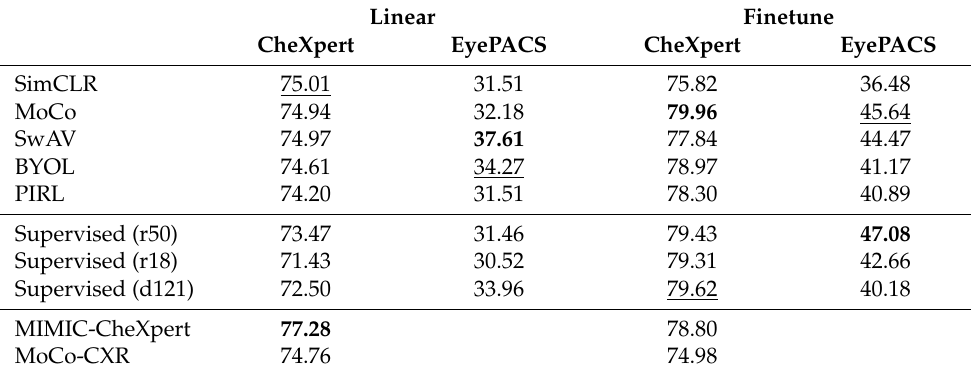
Figure 3. Box-and-whisker plot of model type (SSL models pretrained on ImageNet) against per- formance for few-shot recognition. Performance values are scaled between 0 and 1 for each dataset across all models. The performance on each dataset is plotted as a dot for each model. Table 4. Many-shot shot transfer performance of the pretrained models on the different medical datasets. For EyePACS we do not perform many-shot recognition (linear or finetune) with the domain- specific models (MIMIC-CheXpert, MoCo-CXR), as each run takes over 24 h and we anticipate very poor results, as with few-shot. Key: best , second